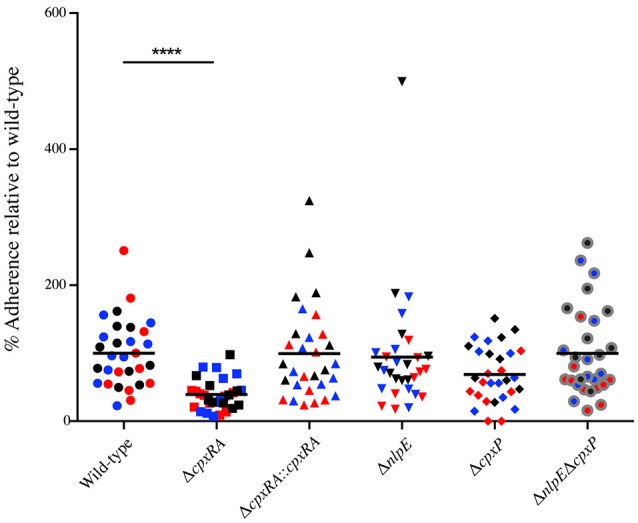
In vitro adherence of wild-type and Cpx TCS mutant strains of Citrobacter rodentium on HeLa cells. HeLa cells were infected with wild-type C. rodentium or a Cpx TCS mutant strain for 8 hrs. The samples were fixed and stained with DAPI and anti-Citrobacter LPS. Samples were imaged on a Zeiss Axiovert 200M microscope. Total number of bacteria per HeLa cell were counted. The 3 biological replicates for each strain are color-coded. Each replicate consists of 10 fields of view. A non-parametric one-way ANOVA was used to determine statistical significance (****P < 0.0001). Bars denote the mean.